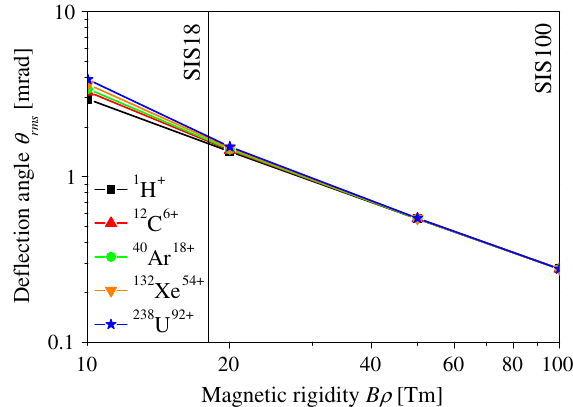
FIG. 1. Dependence of the projected deflection angle θ the magnetic rigidity B ρ for the particles scattered in the 1 mm thick primary collimator made of tungsten calculated by using FLUKA